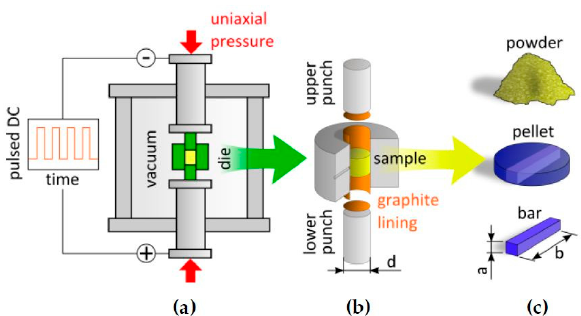
Figure 2. ( a ) Setup of the spark plasma sintering (SPS) machine; ( b ) Scheme of the filled SPS